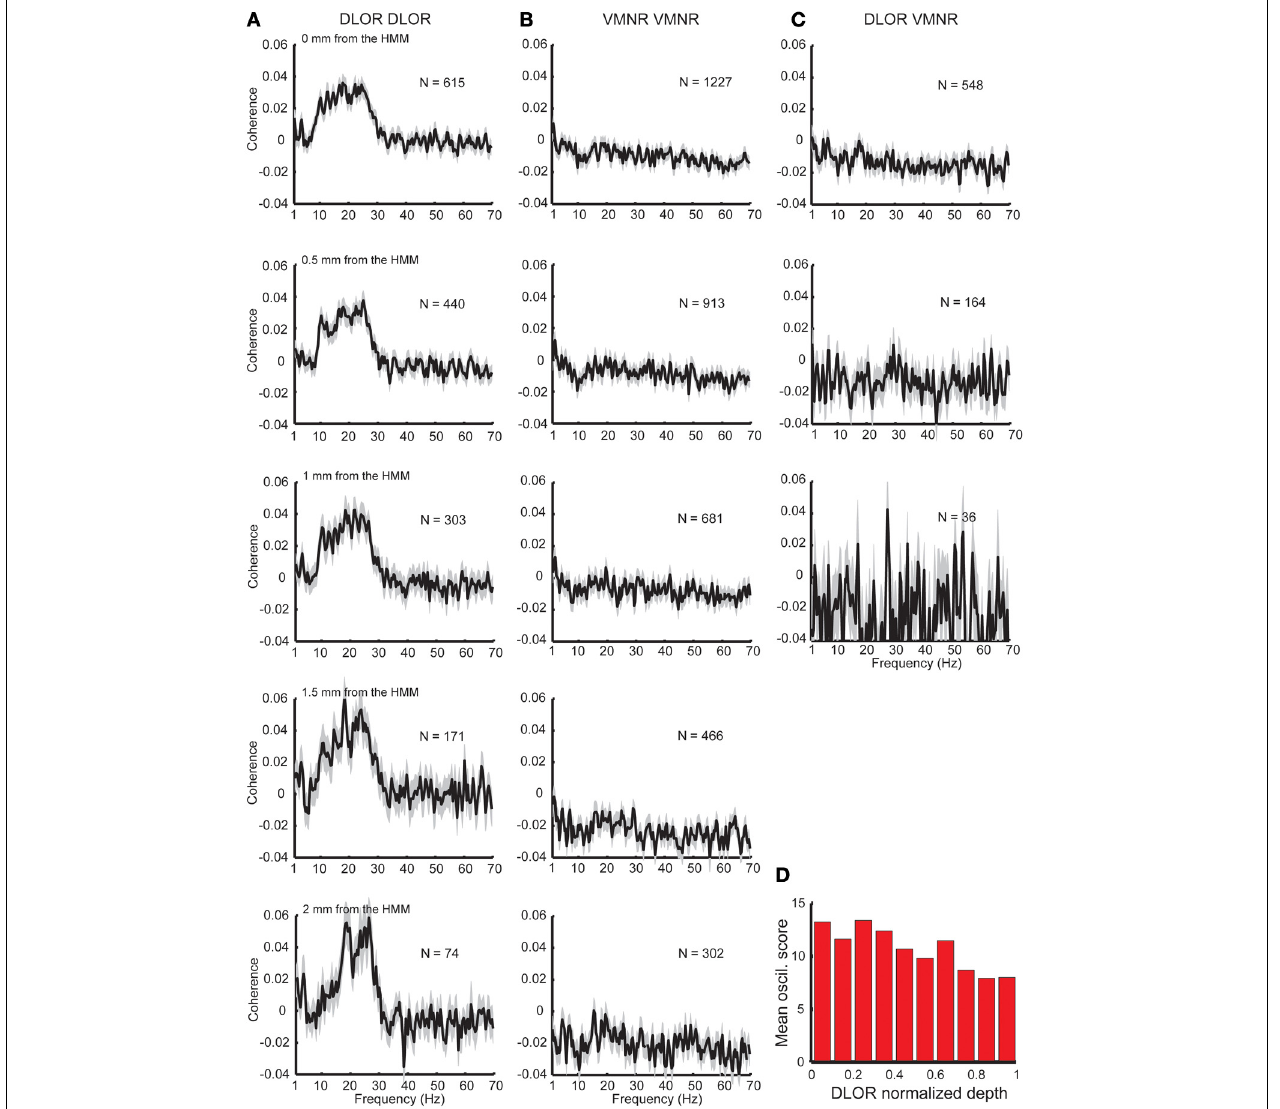
FIGURE 2 | Synchronization found only between sites in the DLOR. (A) Substantial coherence at beta frequency range exists between sites within the DLOR (from the STN entrance to the DLOR\VMNR border). However, the relative coherence is around zero in the beta range for pairs recording from the VMNR (B) , or between sites of the DLOR and VMNR (C) . HMM was used to automatically define the DLOR-VMNR border. The first row is